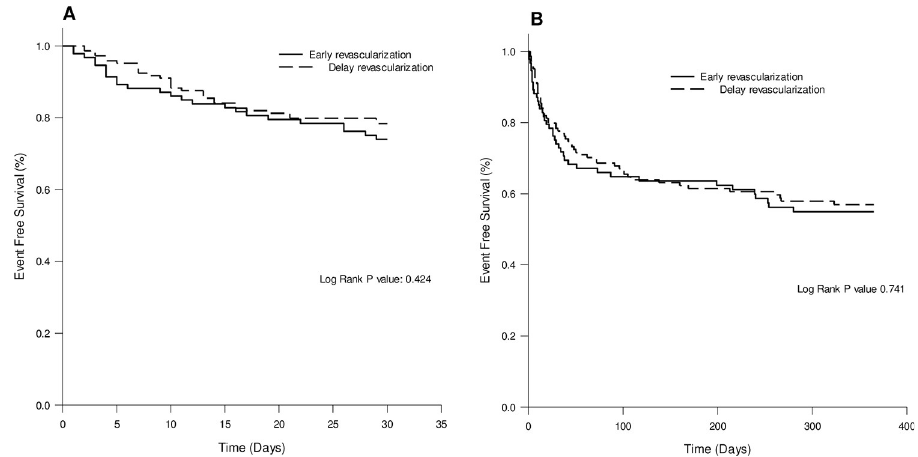
Fig 2. Kaplan-Meier survival curve of all-cause mortality of patients with post infectious ACS according to timing of revascularization. (A) 30-day all-cause mortality (B) one-year all-cause mortality.